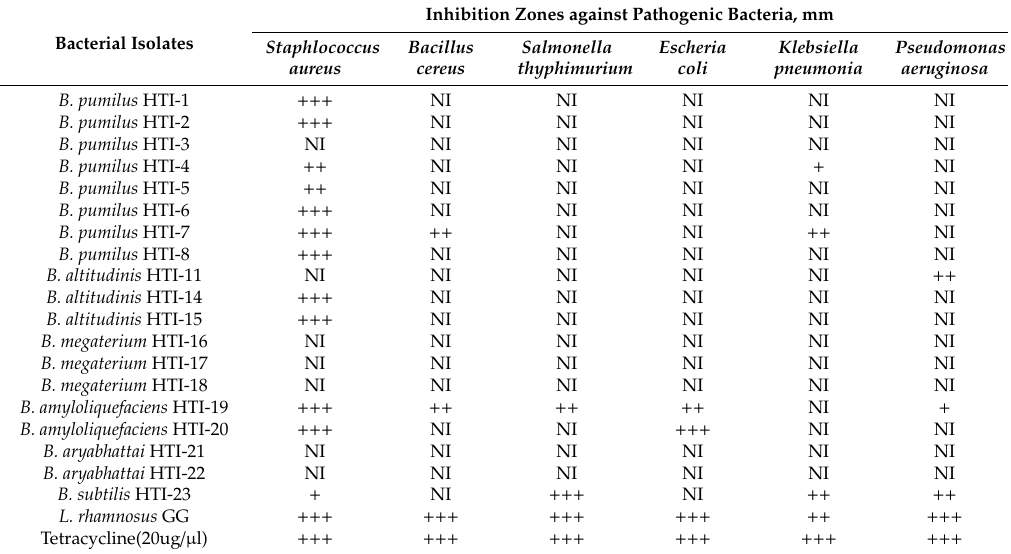
Figure 2. Distribution of the Bacillus species isolated from stingless bee ( Heterotrigona itama ) honey from different geographical locations.